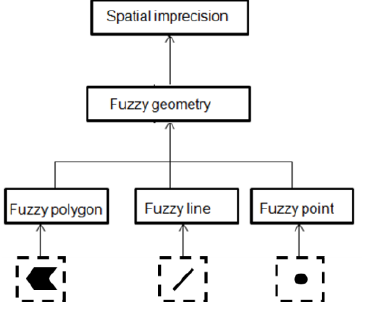
Figure 1. Spatial imprecision in F-Perceptory The approach focuses on three simple spatial shapes: Fuzzy point (0-dimension), Fuzzy line (1-dimension), and Fuzzy polygon (2-dimension).